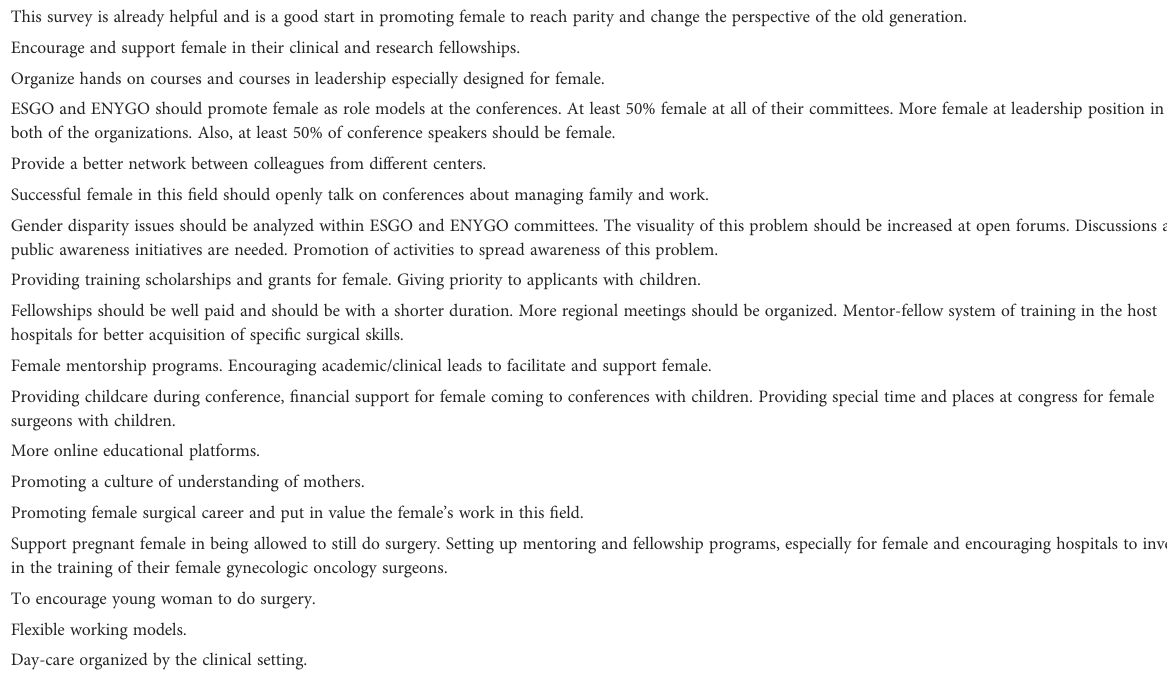
TABLE 5 Selected individual suggestions on how ESGO and ENYGO could help improving the gender disparity in gynecologic oncology surgery.